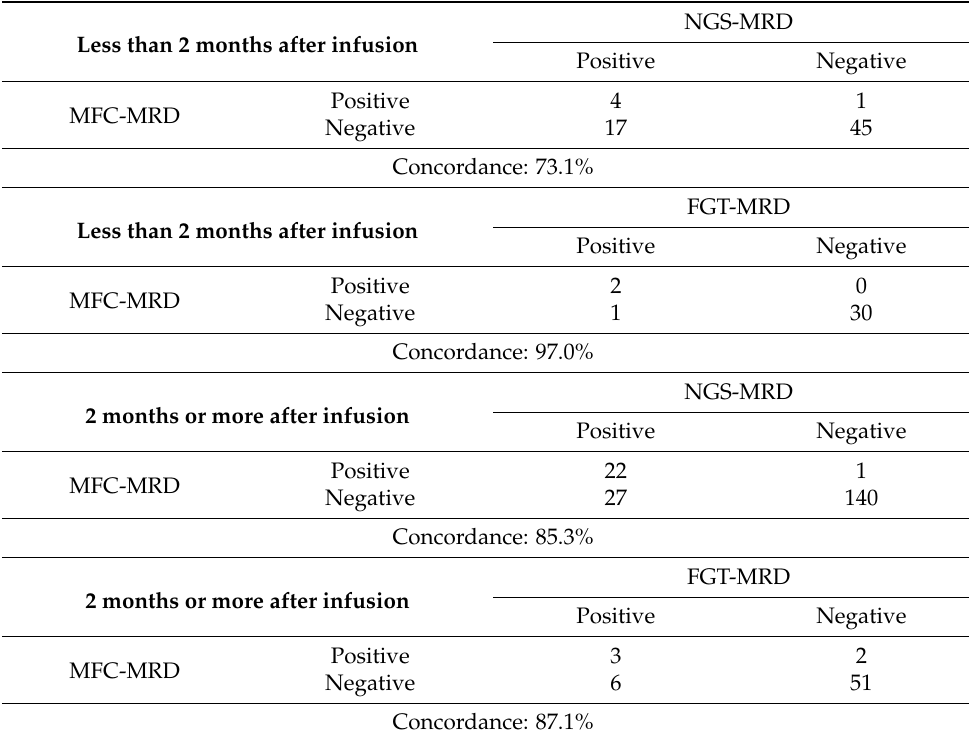
Table 5. Qualitative concordance between MFC-MRD and NGS-/FGT-MRD results according to time point after CD19 CAR-T or CD19/CD22 CAR-T